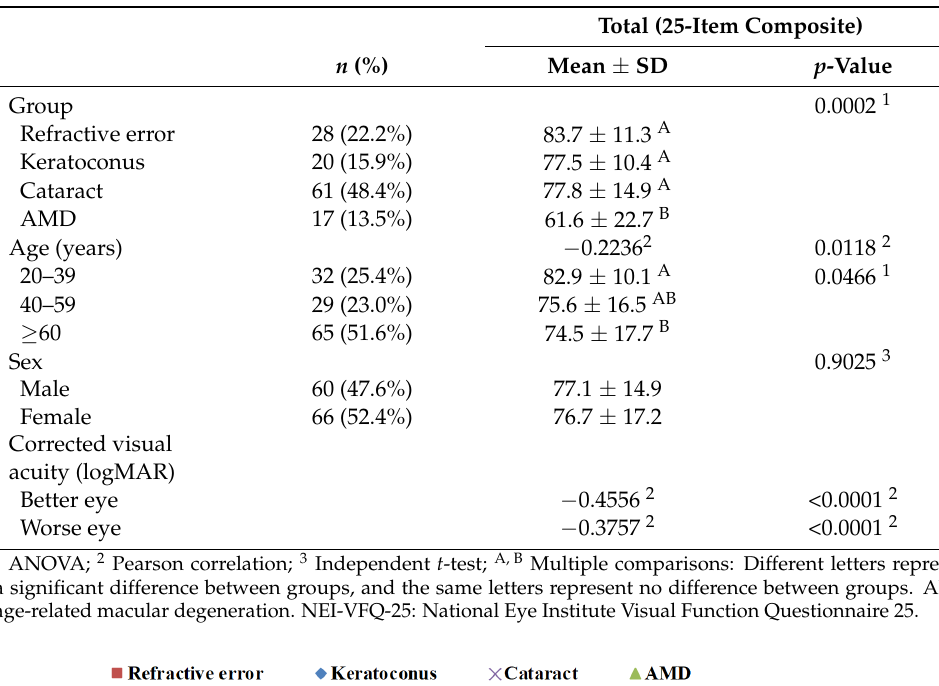
Table 3. Univariate analysis of the total score of NEI-VFQ-25 ( n = 126).